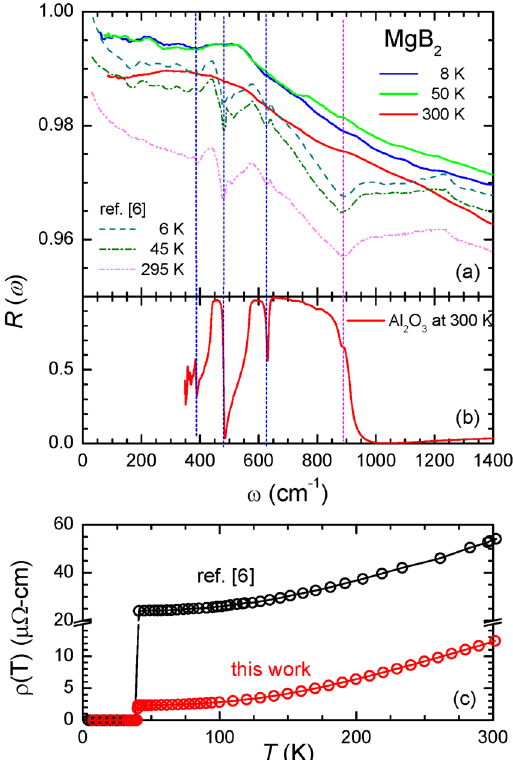
Figure 1. ( a ) Measured reflectivity spectra of our MgB 2 sample, along with previous MgB 2 data obtained by Tu et al . 6 . ( b ) Measured reflectivity spectrum of the Al 2 O 3 substrate at 300 K. ( c ) Measured resistivity of our MgB 2 sample, along with previous MgB 2 data by Tu et al . 6